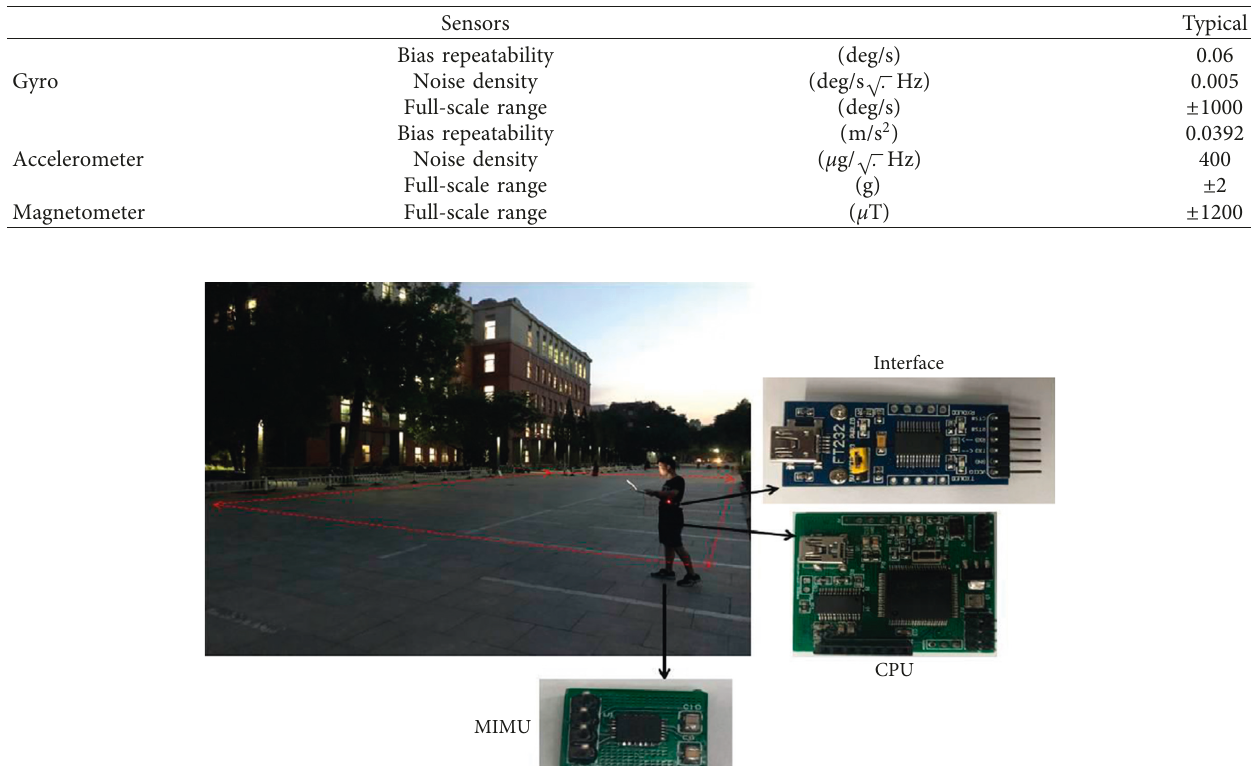
Figure 4: Principle of improved pedestrian location algorithm. Table 1: MPU-9150 parameters.